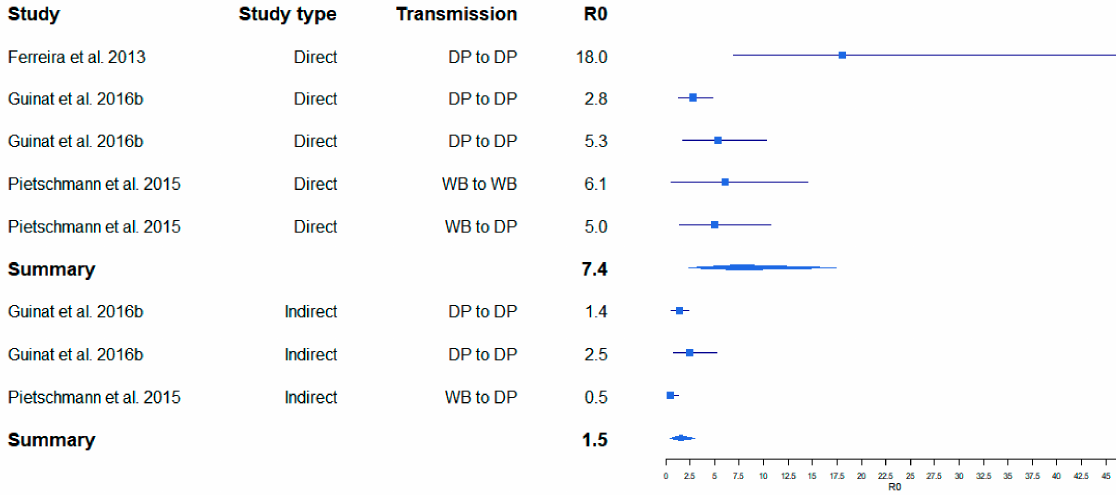
Figure 2. Variation of calculated R 0 for ASF obtained from ASF experimental studies. Boxes illustrate the calculated R 0 . The lines illustrate the confidence intervals. DP = domestic pig, WB = wild boar.